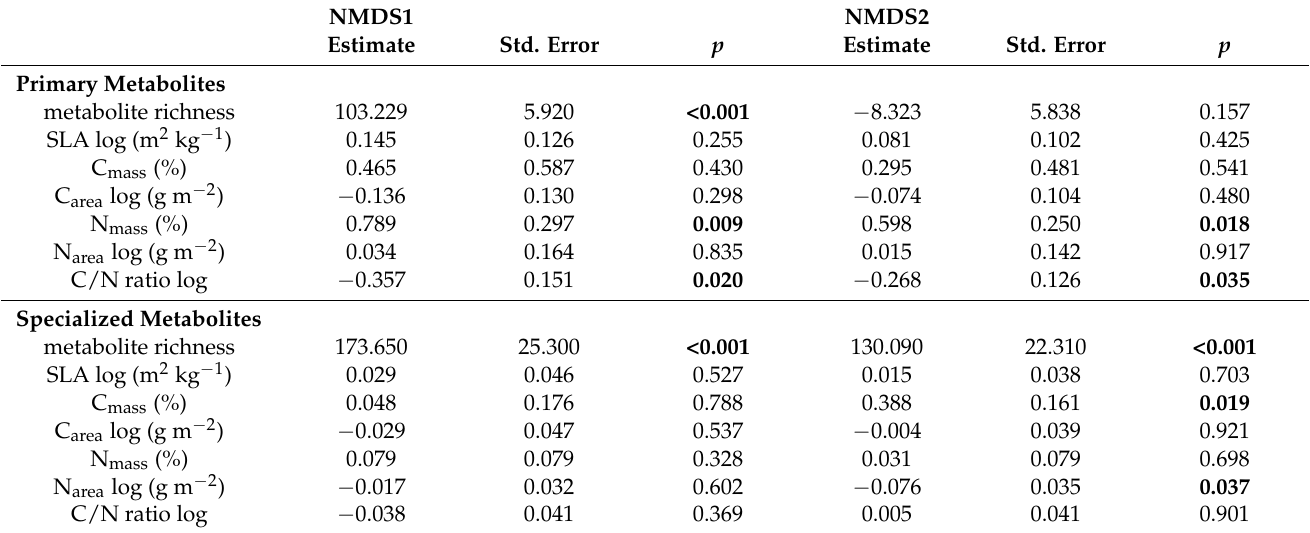
Table 2. Estimates, standard errors and p -values of the linear mixed models used to test the relationships between non-metric multidimensional scaling (NMDS) axes scores (explanatory variables) and metabolite richnesses, SLA, C mass , C area , N mass , N area and C/N ratio. Significant relationships ( p < 0.05) are highlighted in